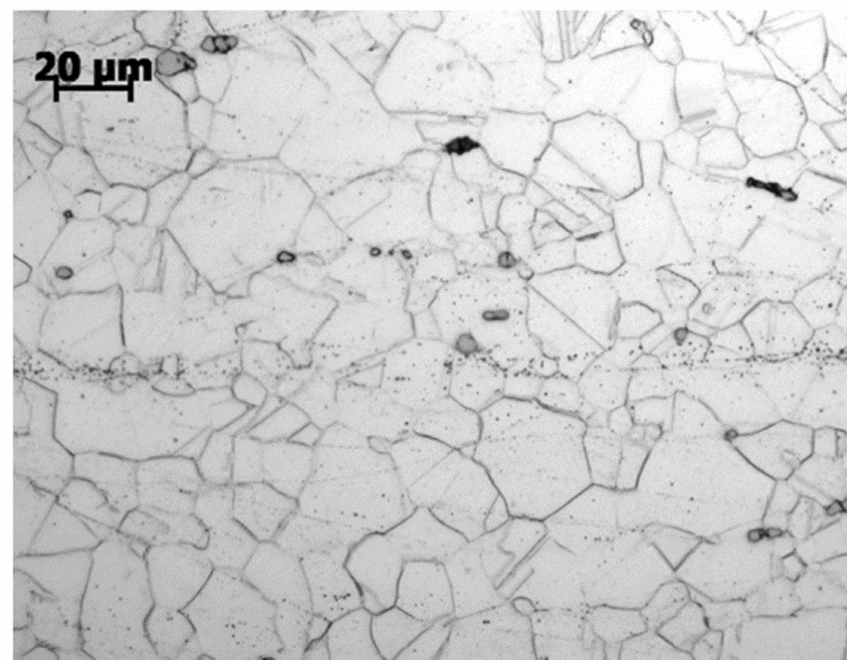
Figure 1. Microstructure of GH4169 alloy after annealing (990 ˝ C/1